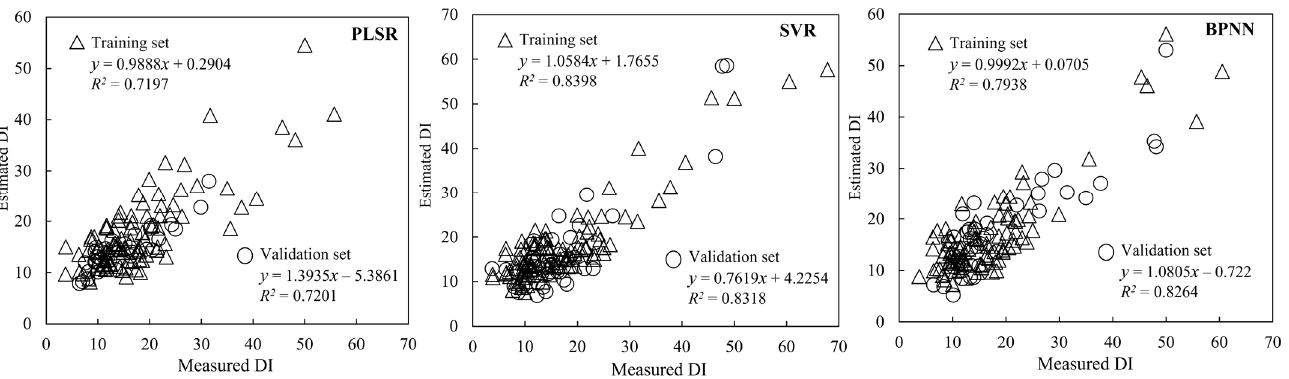
Figure 6. Correlation between different spatial resolution images and vegetation index. The left figure of each subgraph shows the determination coefficient and root mean square error obtained from the correlation analysis of vegetation index and disease index of images with different resolutions. The right image of each subgraph shows the splicing effect of images with different resolutions.